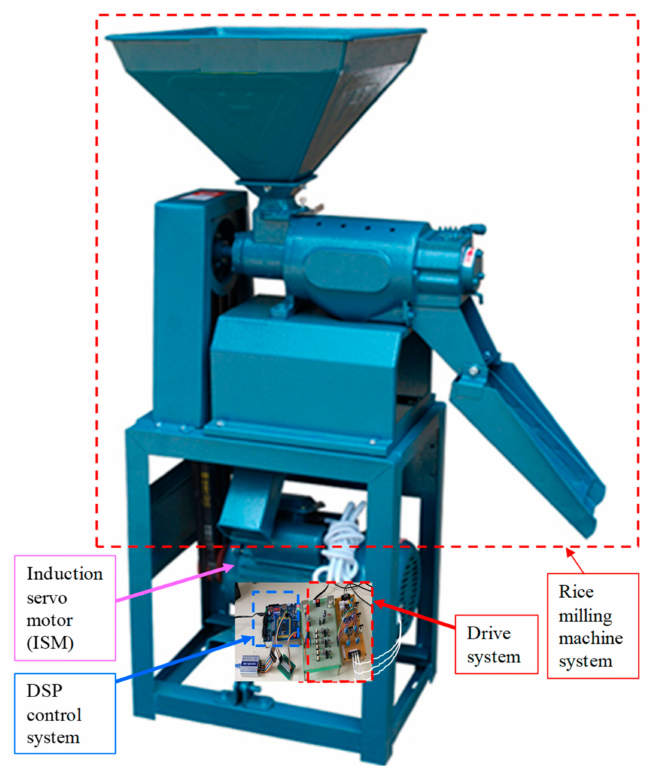
Figure 5. An experimental photo of the ISM and the rice milling machine system. The conversion ratio for the rice milling machine system is 2.2. The profile formats are the belt 1 length is 42.2 mm, the belt 2 length is 52.2 mm, the main idler diameter is 92.6 mm, the diameter of idler 1 is 45.2 mm, and the diameter of idler 2 is 64.2 mm. The specifica- tion of the ISM is three-phase two-pole 220 V, 60 Hz, 3 kW, 3582 rpm. The position and speed conversion ratios are 1 V = 50 rad and 1 V = 50 rad/s. The internal parameters of the ISM are r a = 1.08 Ω , r b = 1.02 Ω , L u = 8.65 mH, L v = 10.68 mH, L uv = 8.89